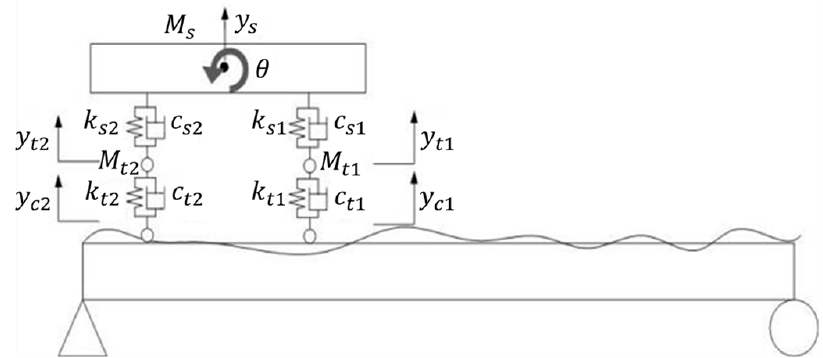
Figure 2. Coupling effect of the vehicle and bridge.